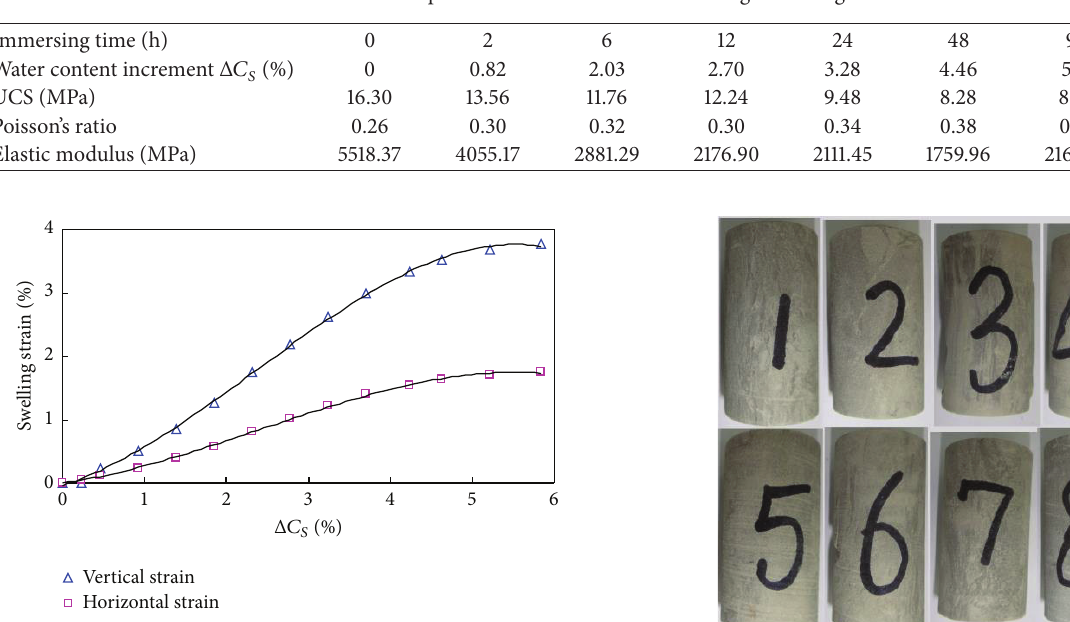
Table 2: Experiment results of cores immersing in drilling fluid.